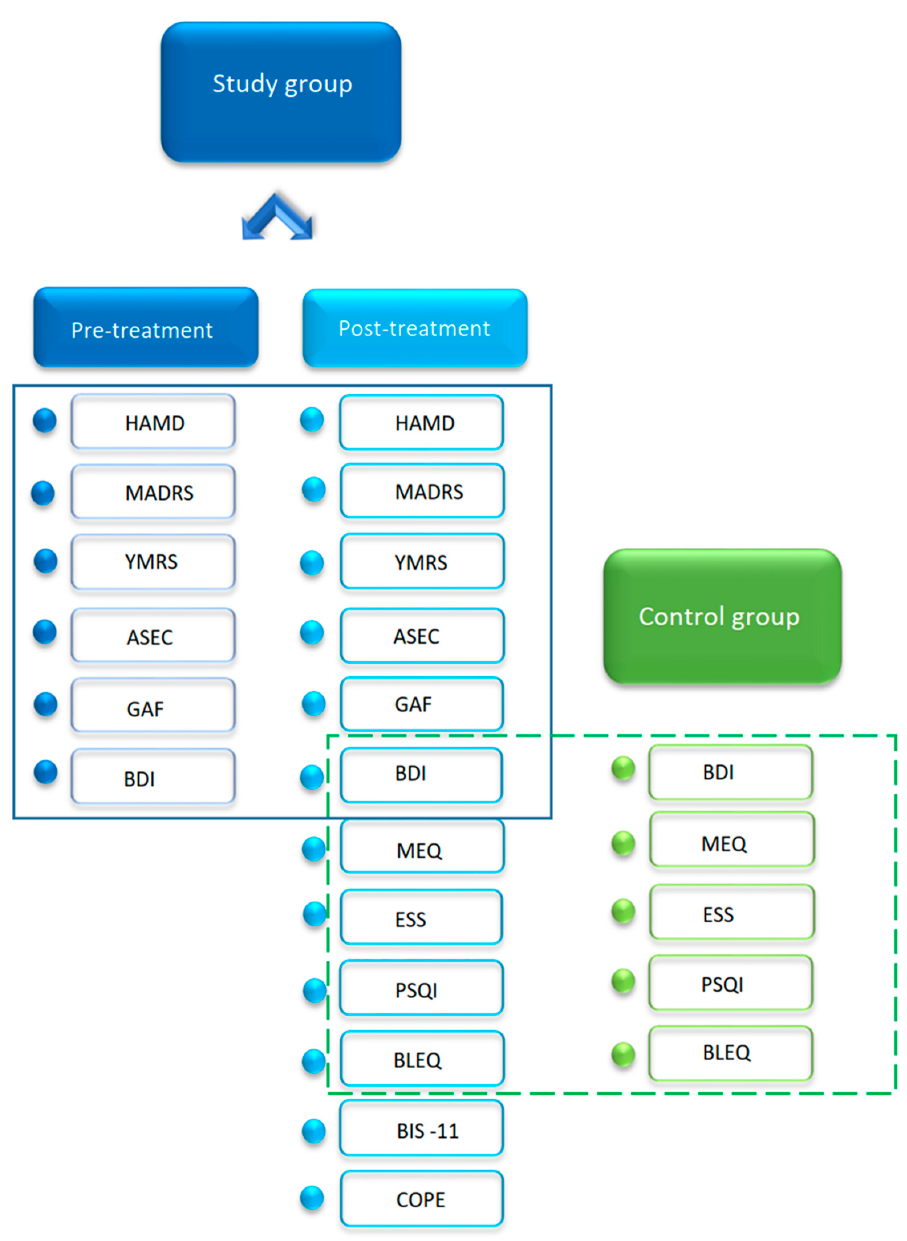
Figure 1. Questionnaires used in the study. The box marks the common tests for each group: the solid line for patients in pre- and post-treatment state, and the dotted line for post-treatment patients and control group. Abbreviations: HAMD—Hamilton Depression Rating Scale,